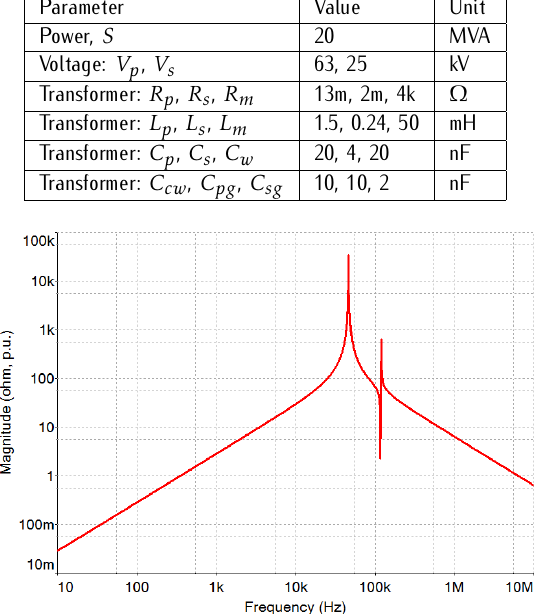
Figure 2. Equivalent impedance seen by the traction side of a typical 20 MVA traction